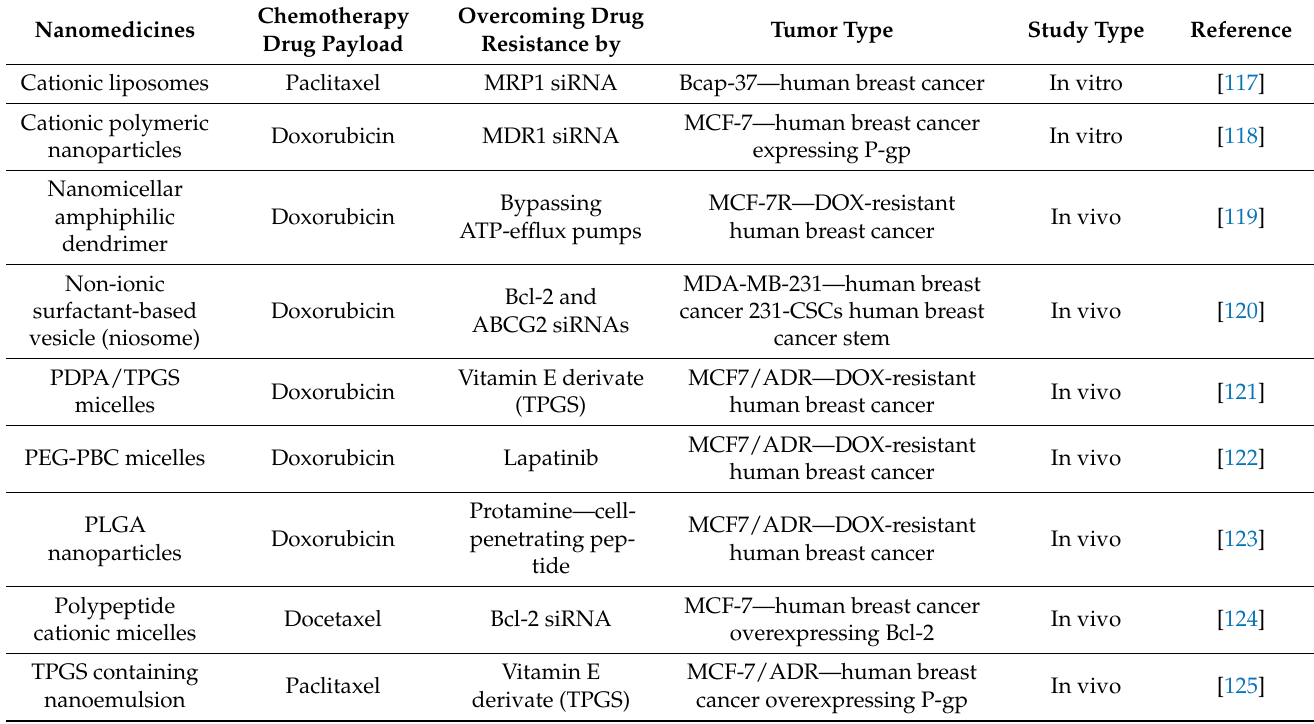
Table 1. Passive drug targeting-based nanomedicines currently undergoing evaluation